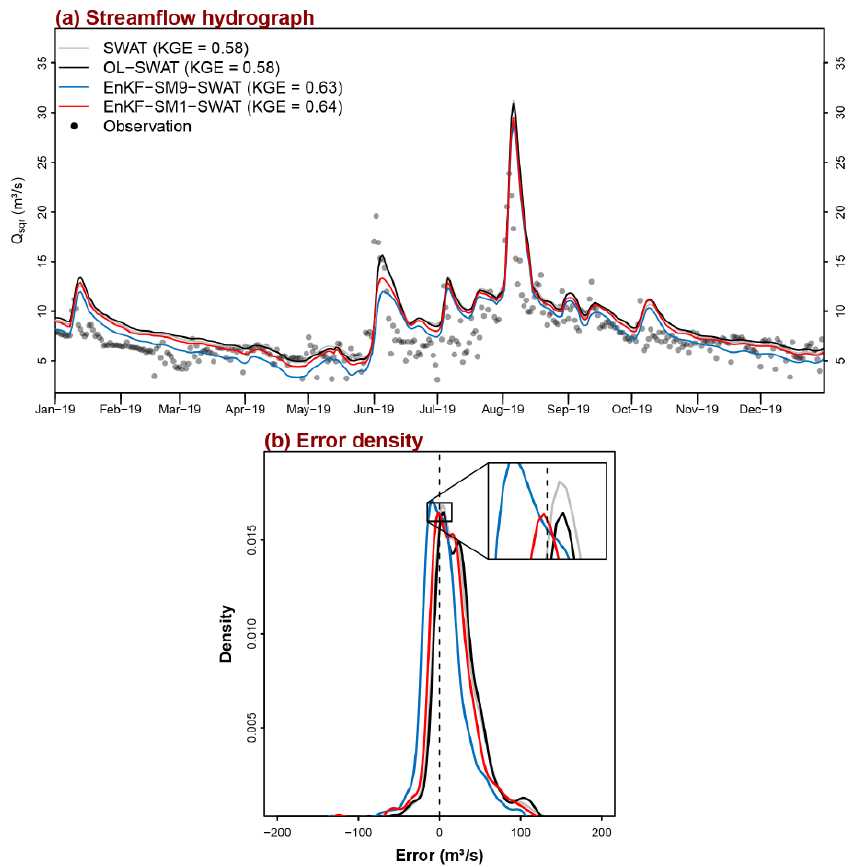
Figure 7. ( a ) Streamflow hydrograph comparison, and ( b ) error density between observed and simulated streamflow from different hydrological SWAT simulation scenarios during the year of 2019 at xla river basin. The black dash line in ( b ) is the zero error vertical line. The inlet panel in ( b ) zooms in the peak error density from different simulation